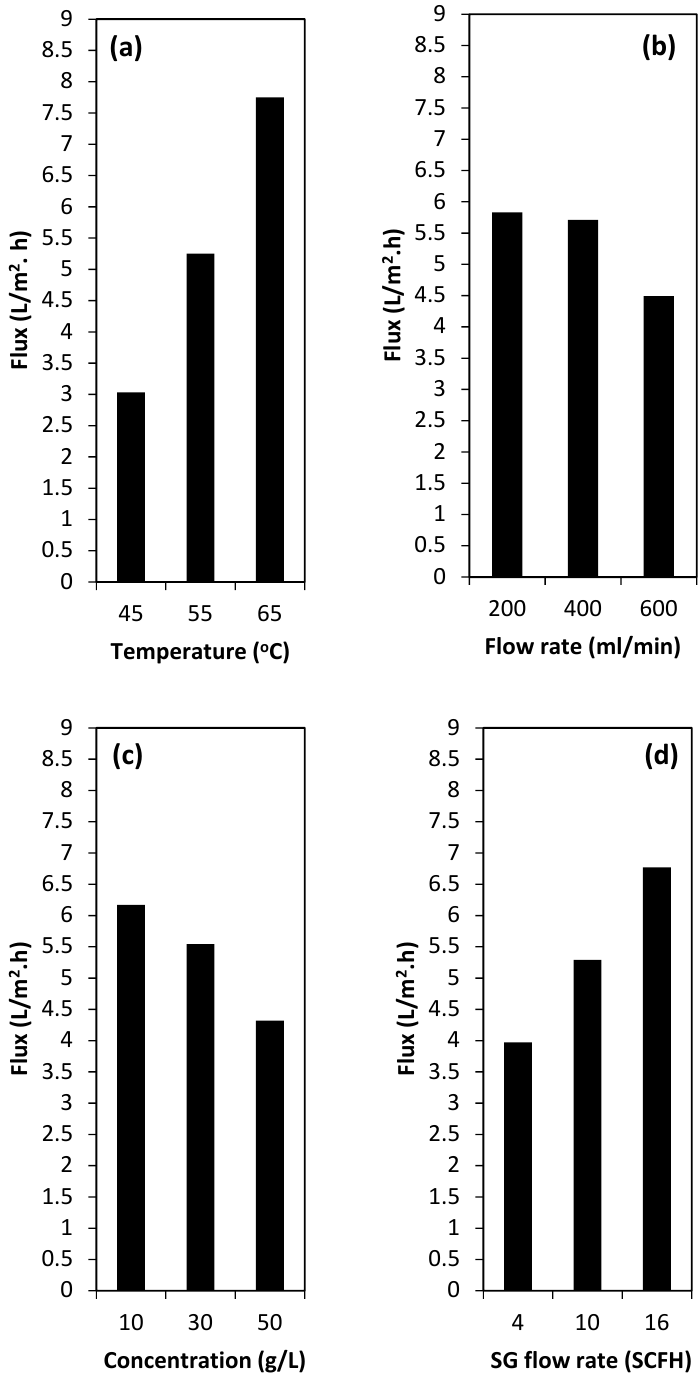
Figure 3. The main effects of feed temperature ( a ), feed flow rate ( b ), feed concentration ( c ), and sweeping gas flow rate ( d ) on the permeate flux based on the operating conditions from the Table 3. Table 4. Responses for the Taguchi analysis of the permeate fluxes; T h (feed temperature), Q h (feed flow rate), C (feed concentration), and Q a (sweeping gas flow rate).